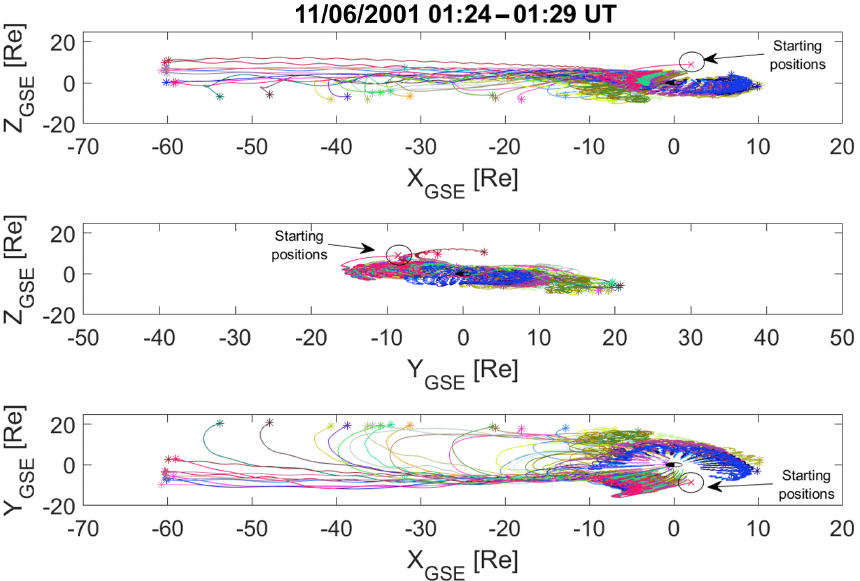
Figure 3. Example of 40 O + varied trajectories (different colours) from the plasma mantle on 11 June 2001 between 01:24 and 01:29UT. The crosses denote the starting positions, whereas the asterisks denote the ending positions in the